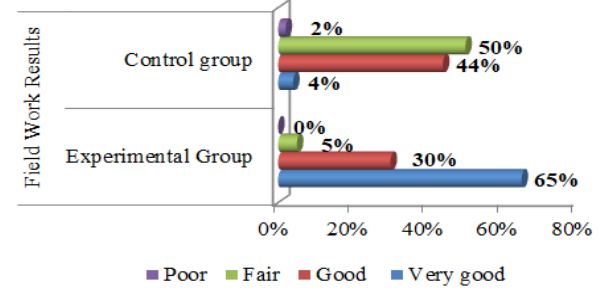
Fig. 2 Percentage of achievements in fieldwork of experiment and control